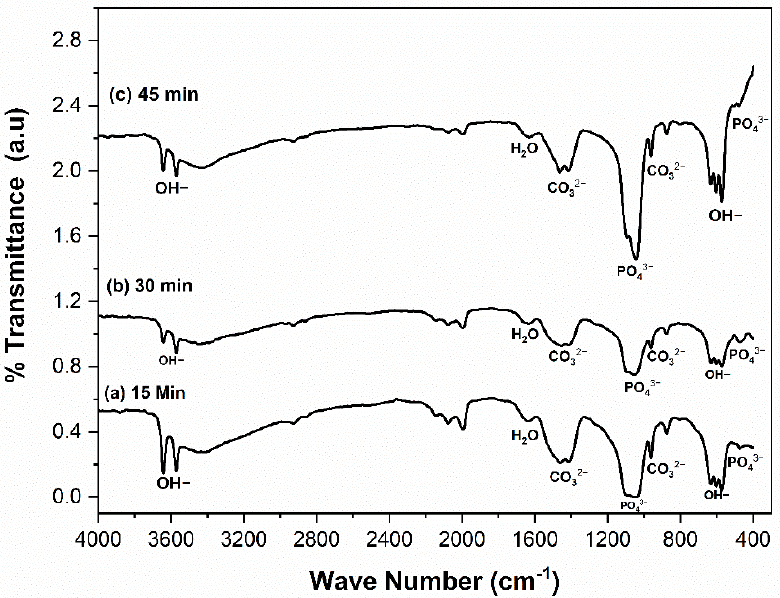
Figure 3. FTIR spectra of CHA with stirring times of: ( a ) 15 min; ( b ) 30 min; ( c ) 45 min.